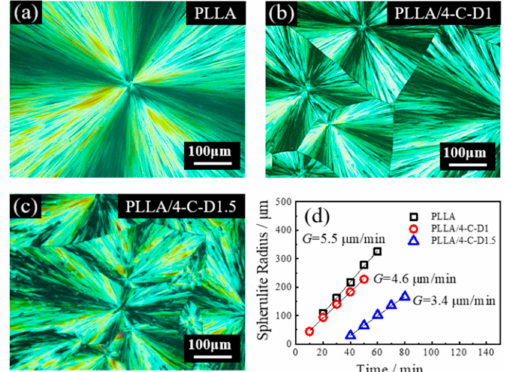
Figure 3. Spherulite morphologies and radial growth rates for PLLA and the PLLA / 4-C-D blends.